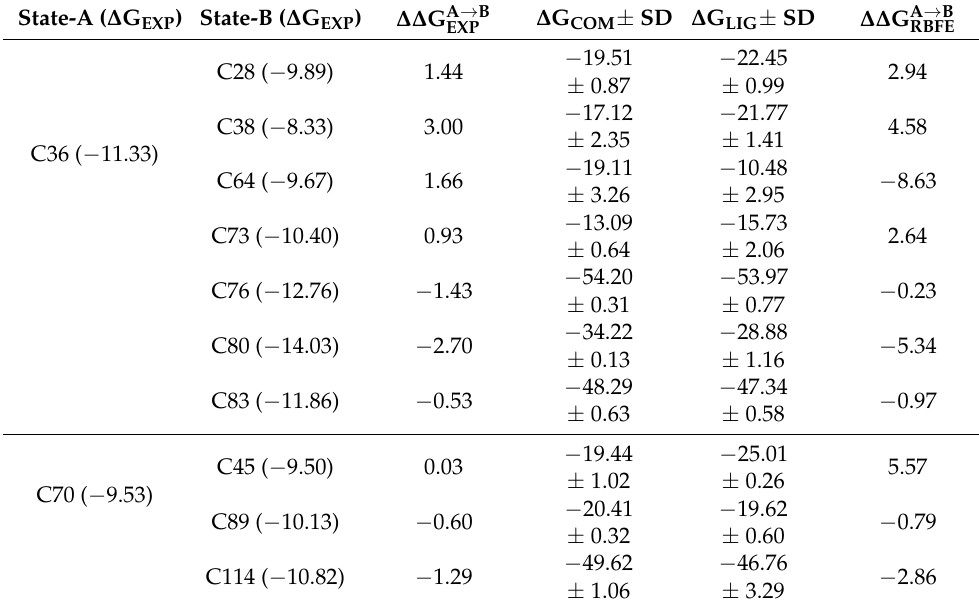
Table 2. Energy terms of alchemical binding energy transformation from state-A to